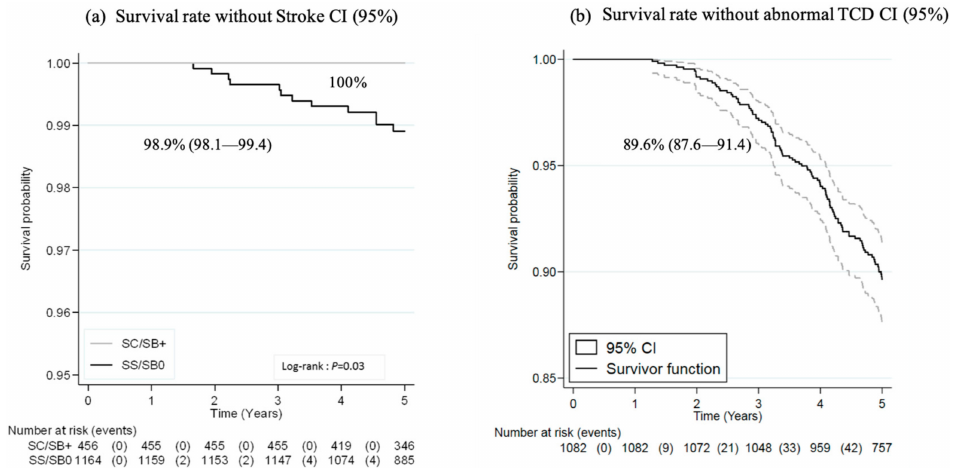
Figure 3. ( a ) Probability of survival without stroke; ( b ) probability of survival without abnormal transcranial Doppler (TCD) in children with SS / SB ◦